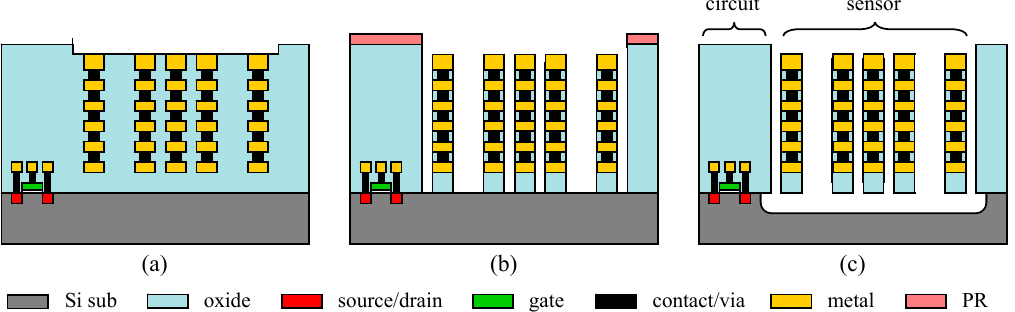
Figure 7. Fabrication process of proposed CMOS-MEMS accelerometer.